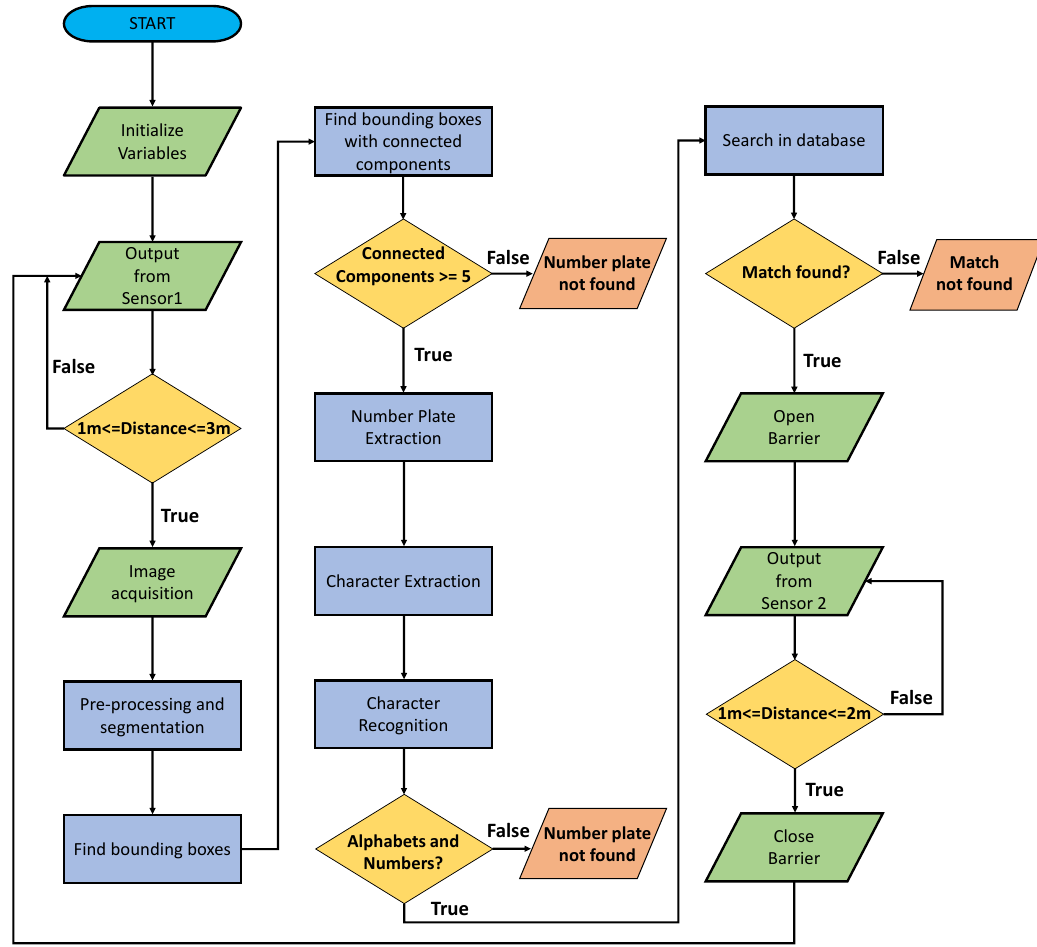
Figure 3. Algorithm flow chart of the proposed smart access control for vehicle entrance using sensors platform and an image-based LP